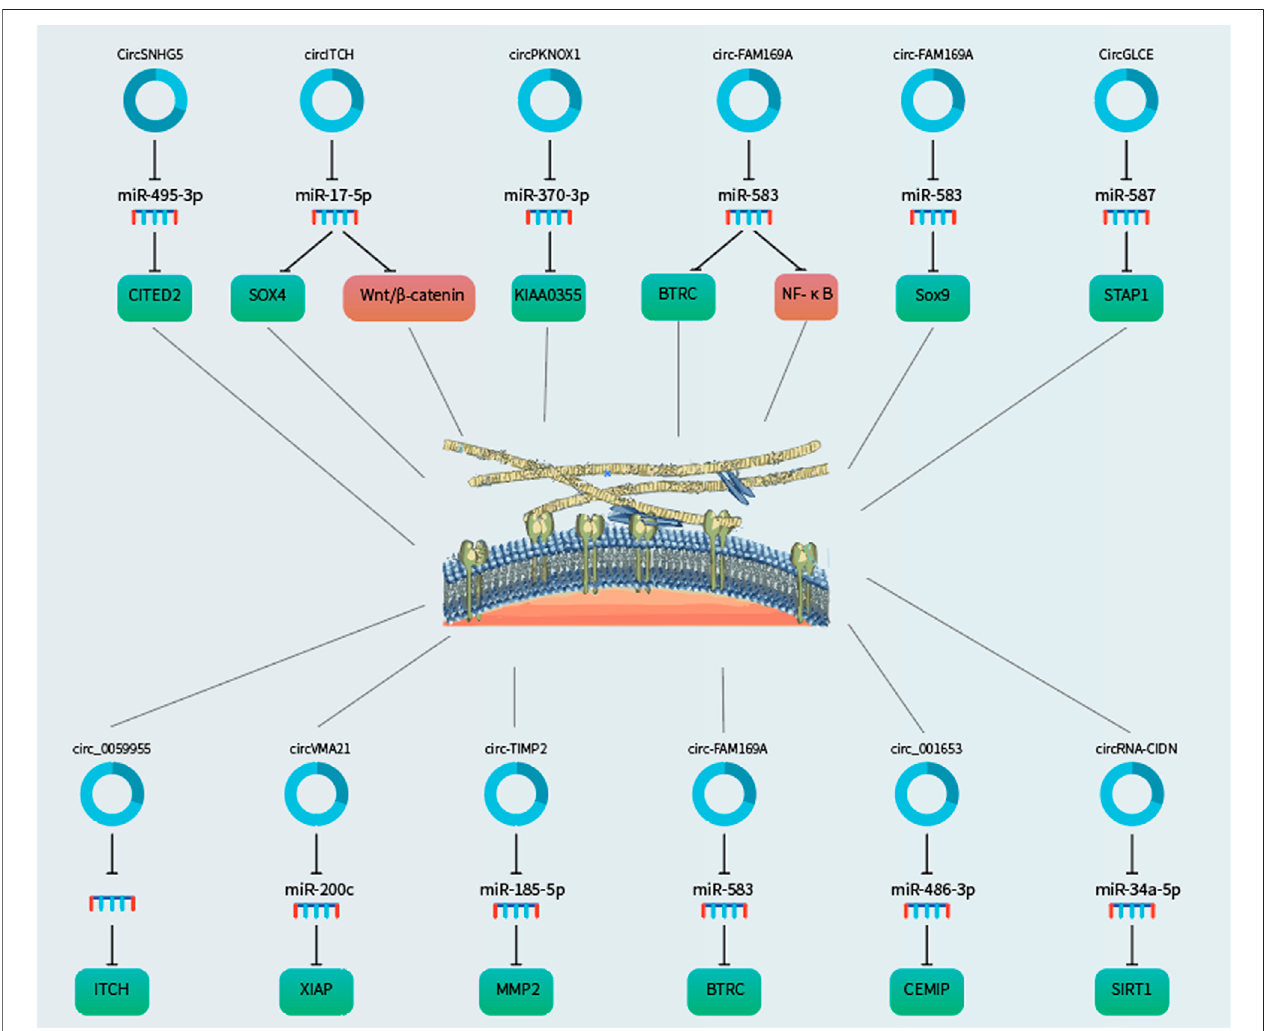
FIGURE 3 | CircRNAs as regulators of ECM remodelling in the NP cells via sponging microRNAs to derepress the downstream target genes.